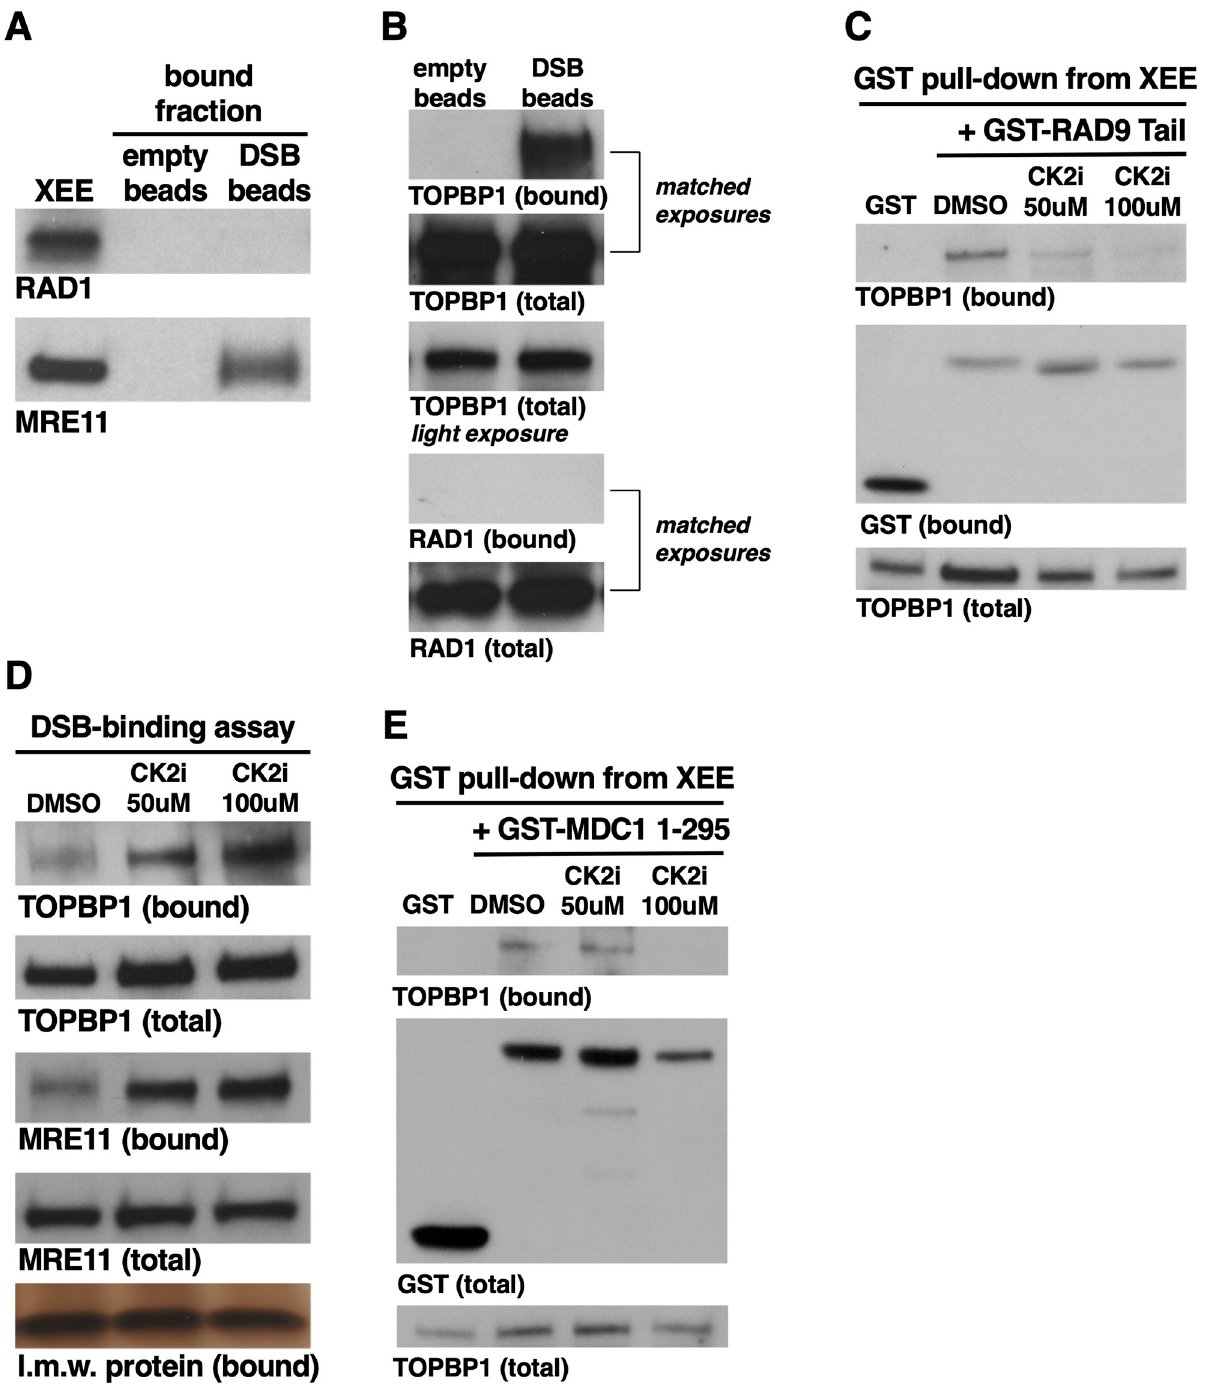
Fig 7. Neither the 9-1-1 complex nor MDC1 are required for TOPBP1 recruitment to DSBs. A. A DSB binding assay was performed and the bound fraction was probed for the indicated proteins. The experiment shown is representative of two independently performed biological replicates. B. A DSB binding assay was performed and samples from total extract and the bound fraction was probed for the indicated proteins. For the total extract samples, 1 ul of XEE was loaded on the gel. Please see text for explanation of “matched exposures”. The experiment shown is representative of two independently performed biological replicates. C. A GST pull-down experiment was performed. The indicated GST fusion proteins were added to XEEs that had been treated with the indicated compounds and, after incubation, complexes were isolated back out of the extract via glutathione-sepharose beads and probed for the indicated proteins. Samples of the total extract were also probed for TOPBP1. The experiment shown is representative of two independently performed biological replicates. C. A DSB-binding assay was performed with XEEs treated with the indicated compounds at